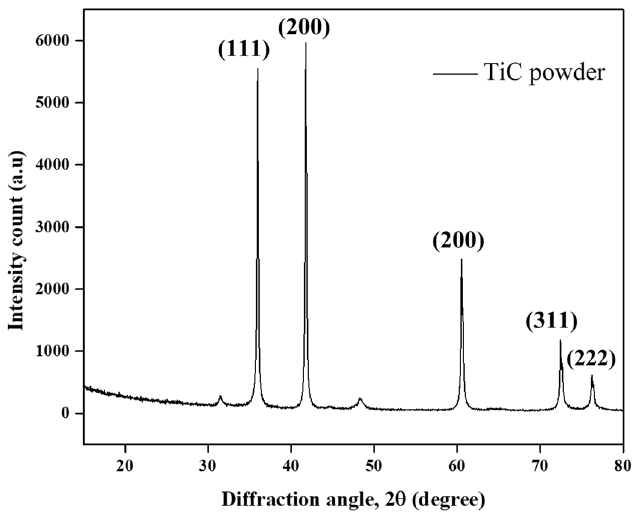
Figure 11. XRD pattern of the TiC powder.